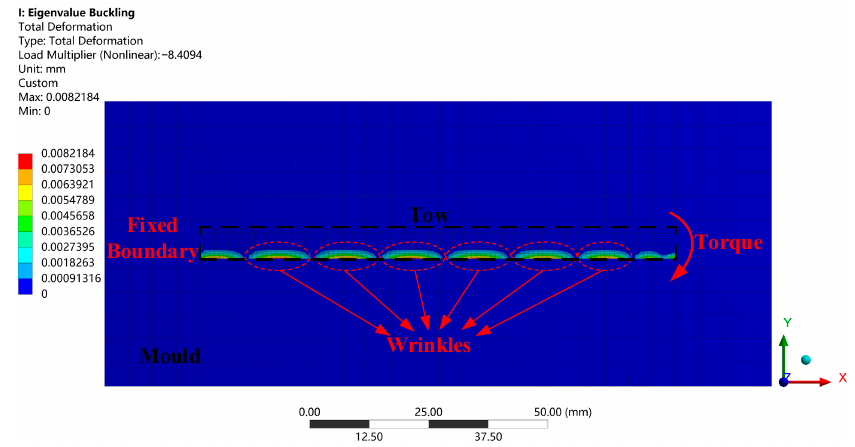
Figure 10. Simulation results of tow buckling.